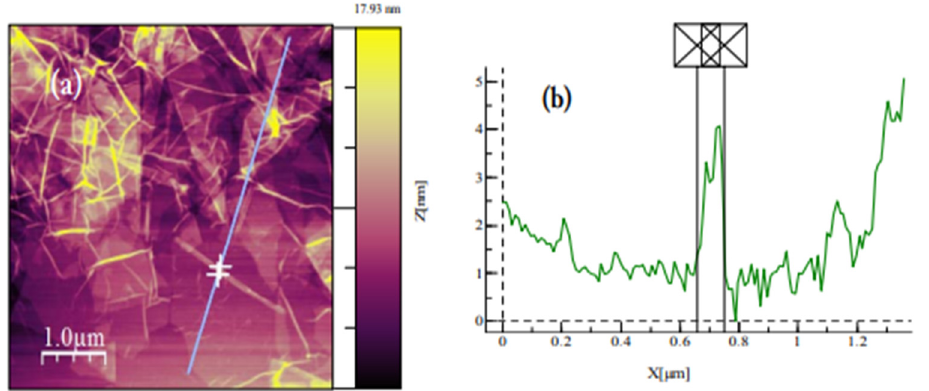
Figure A9. TEM images of ( a ) thin GO sheet, ( b ) HETEM of single-layer GO sheet and ( c ) SAED pattern of GO.